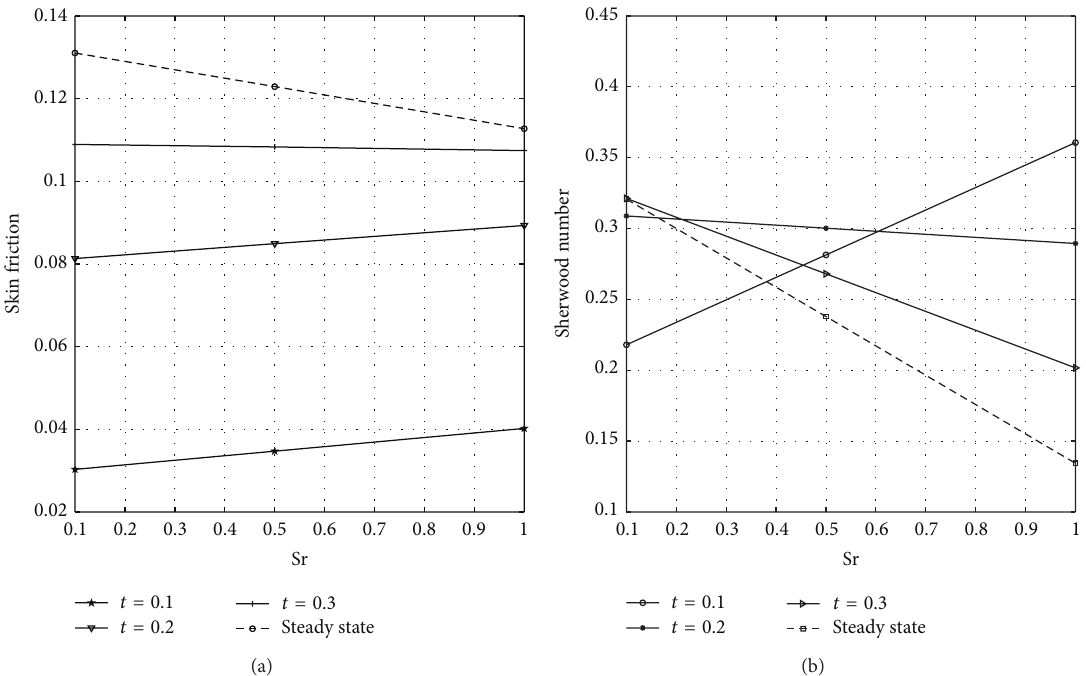
Figure 13: Variation of skin friction and Sherwood number with Sr and time ( 𝑡 ) at 𝑦 = 1 .